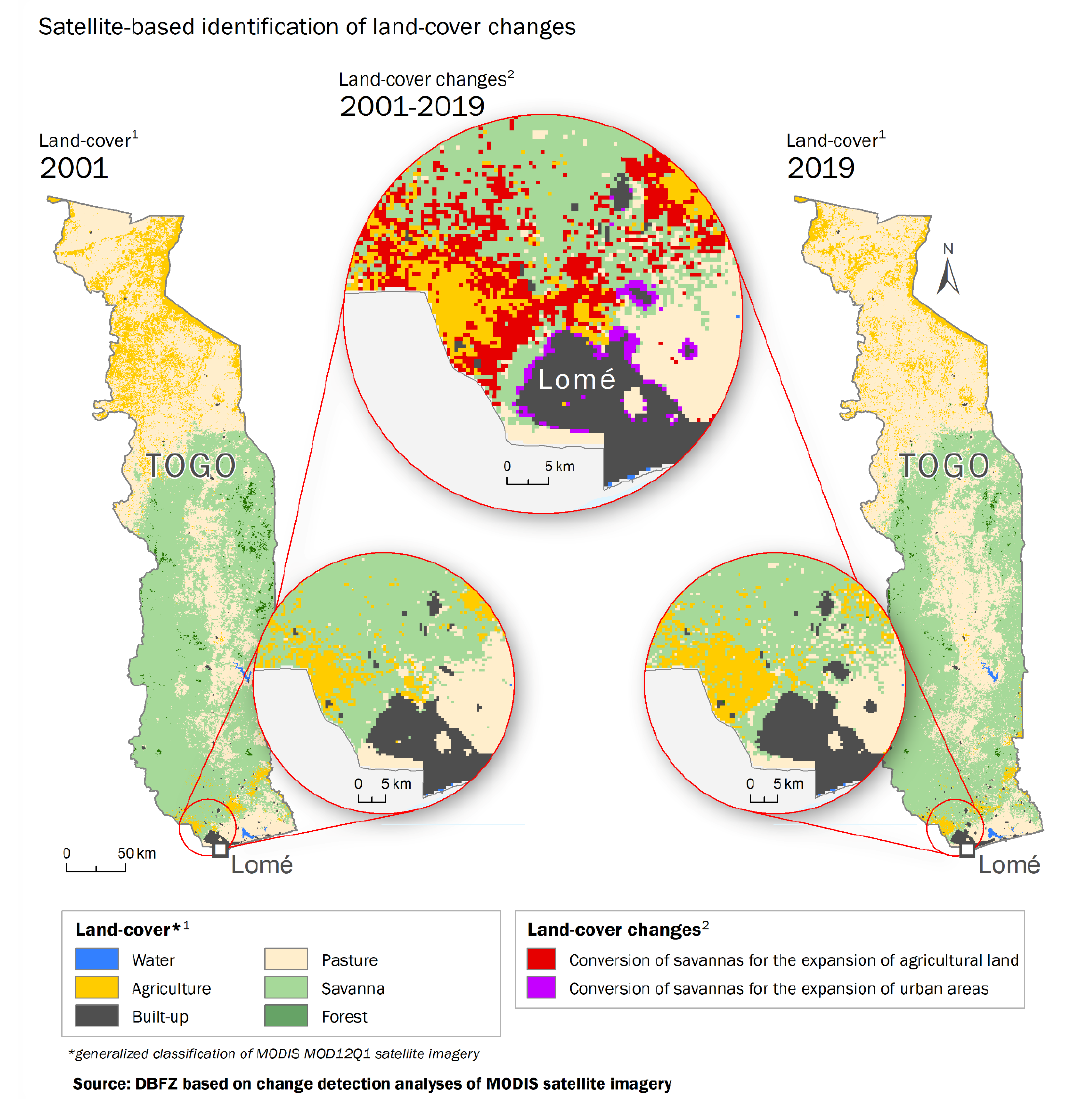
Figure 7 Simplified visualization of Change Detection analysis for the identification of preference region for biogas